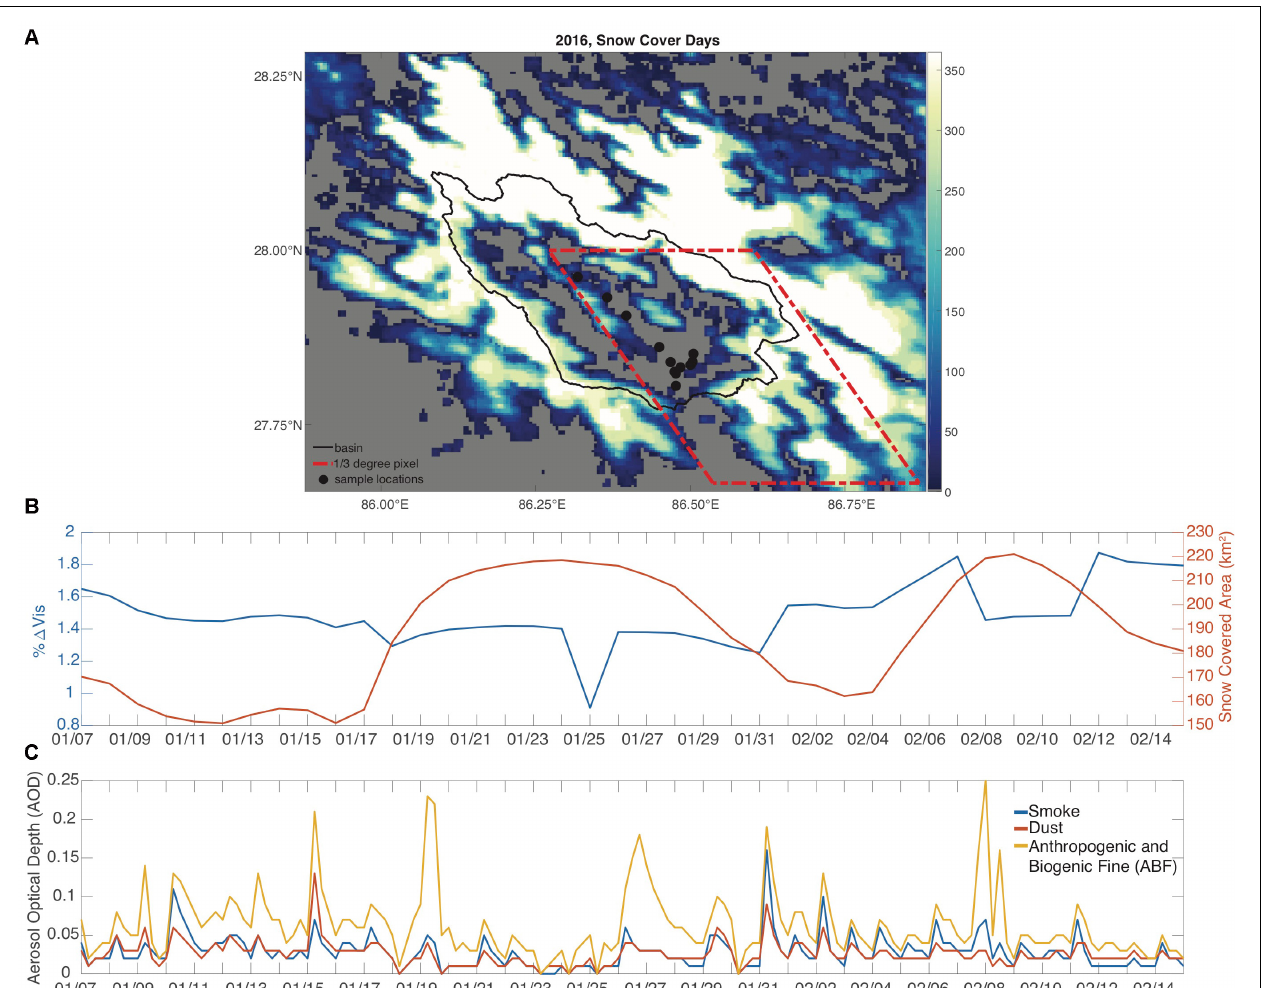
FIGURE 5 | (A) Map of snow cover fraction on 8 February 2016 with location of the Dudh Koshi River Basin, samples locations and corresponding Navy Aerosol Analysis Prediction System model (NAAPS) 1/3 ◦ pixel, which is used for (C) . (B) Snow covered area and (cid:49) vis during the sampling period (C) NAAPS Speciated Aerosol Optical Depth across a 1/3 ◦ MODIS gridded area of the study region during the sampling period. Snowfall events occurred on 18 January and 5 February 2016.